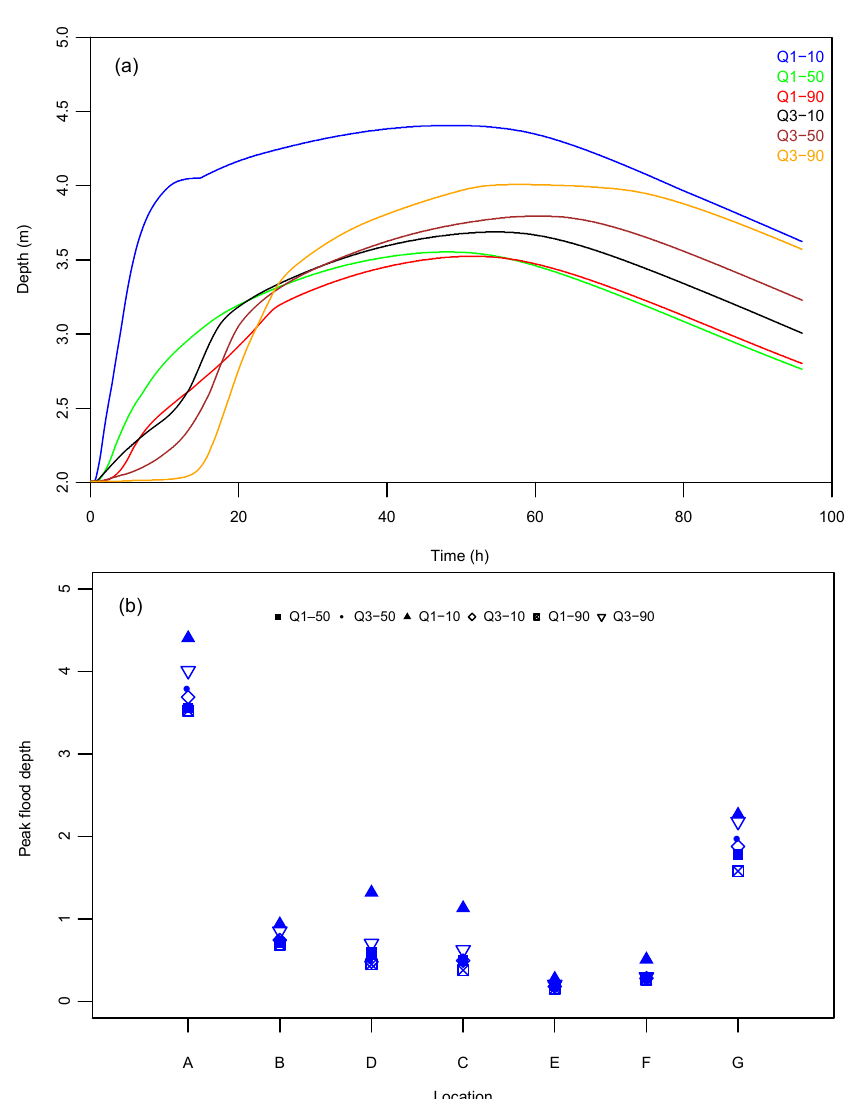
Figure 6. (a) Depth over time at Wilmes Lake (location A), which is the downstream regional reference point in Fig. 1. Depth vs. time curves are plotted for 160mm of total rainfall over 24h with the six temporal patterns. Panel (b) presents the variation of peak flood depth (m) at reference locations throughout the watershed (refer to Table 1) with variation of temporal patterns for a total of 160mm of rainfall over